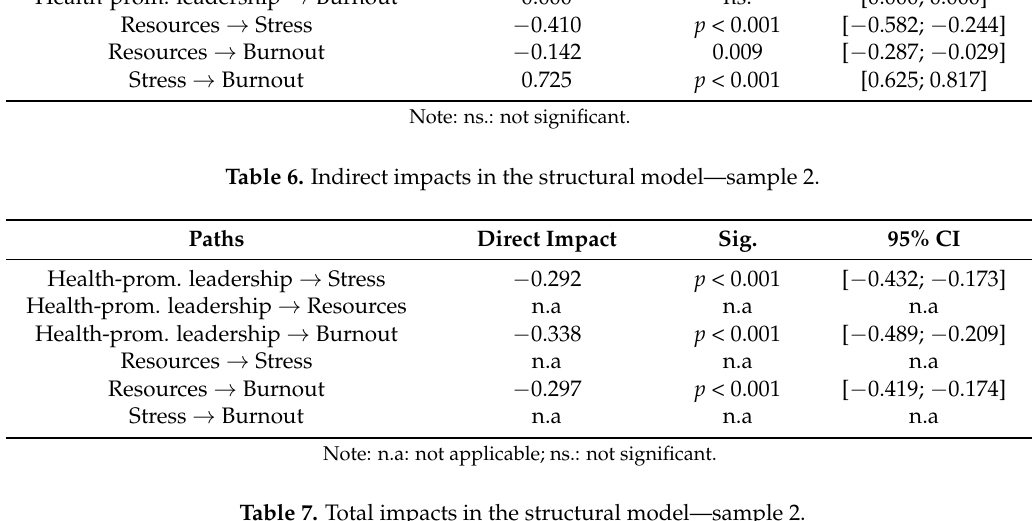
are significant at p < 0.05.